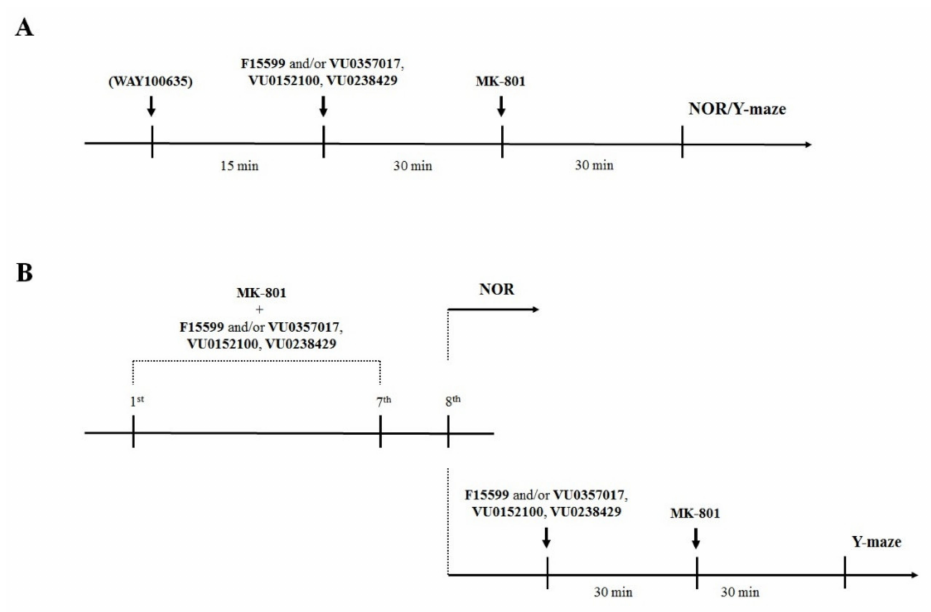
Figure 2. Schematic representation of the experiments performed in this study. ( A ) Acute administra- tion of the investigated compounds and MK-801. ( B ) Prolonged administration of the investigated compounds and MK-801.